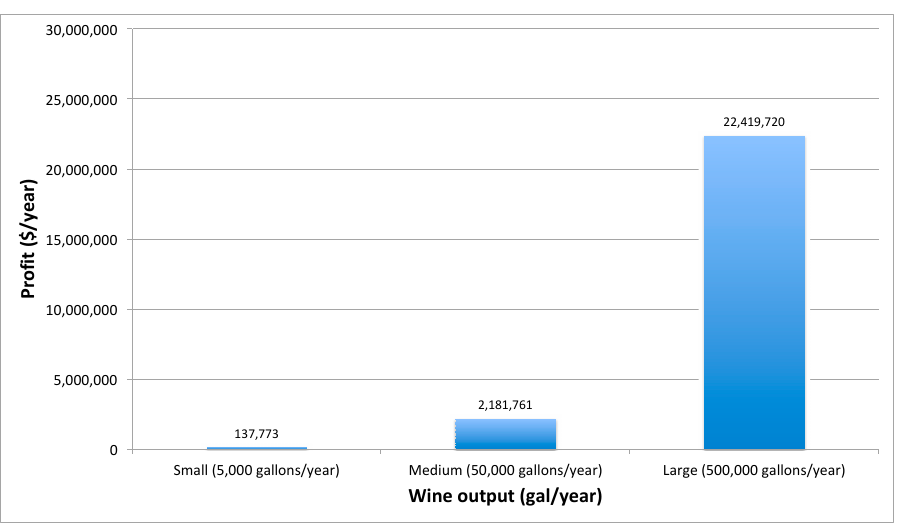
Figure 9. Annual revenues according to scale of operation (showing linear trendline).